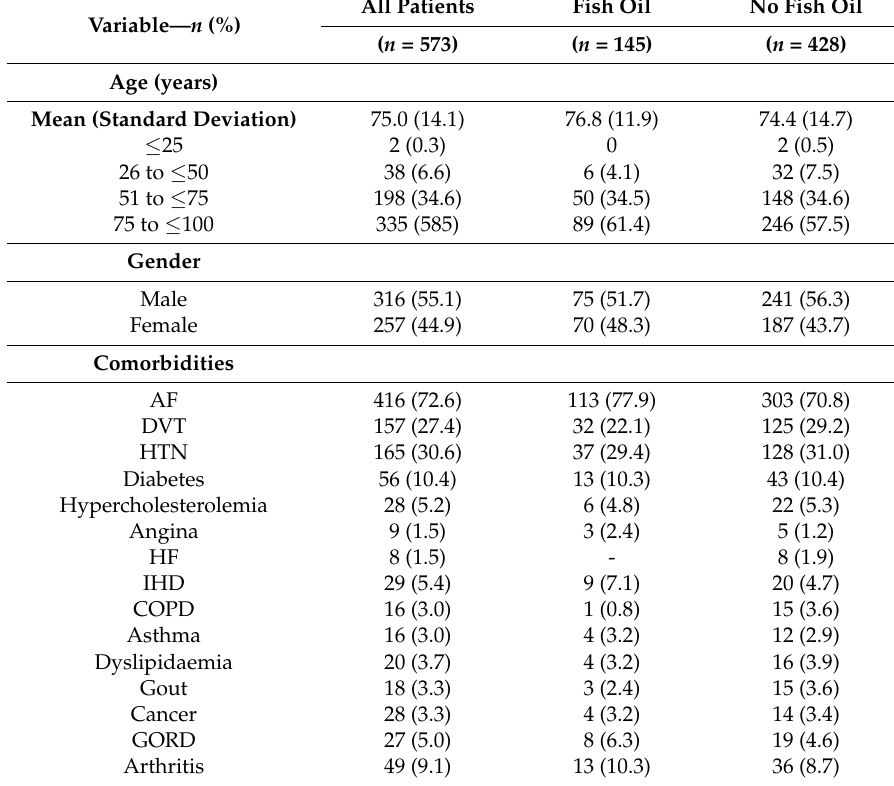
Table 1. Demographic characteristics of patient